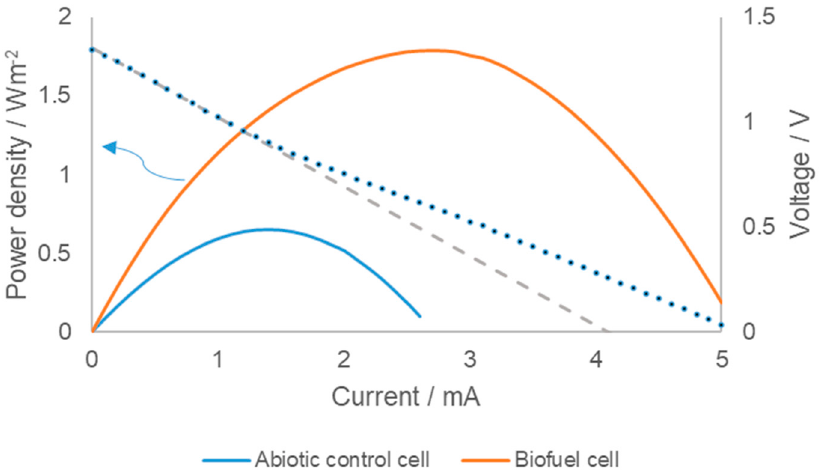
Figure 2. Polarisation profile and the subsequent power density profile of the biofuel cell. The abiotic control cell comprising a zinc anode and air cathode in a PDB electrolyte, which was slightly acidic (pH 6.5).